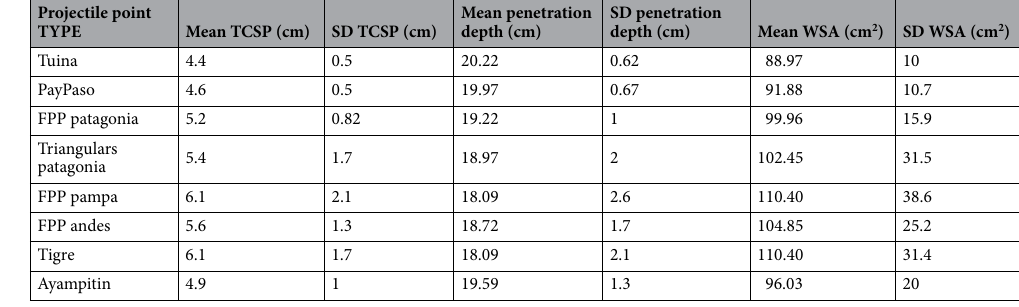
Table 2. Estimated mean and standard deviation (SD) TCSP, penetration depth and WSA of the FPP, Tigre, Tuina, Triangulars, Ayampitín and Pay Paso projectile points. The Penetration depth was calculated from the lineal formulae of TCSP versus penetration depth, based on the experimental results of Sitton et al. 39 . WSA was calculated as the product of TCSP by the estimated Penetration depth 36 .